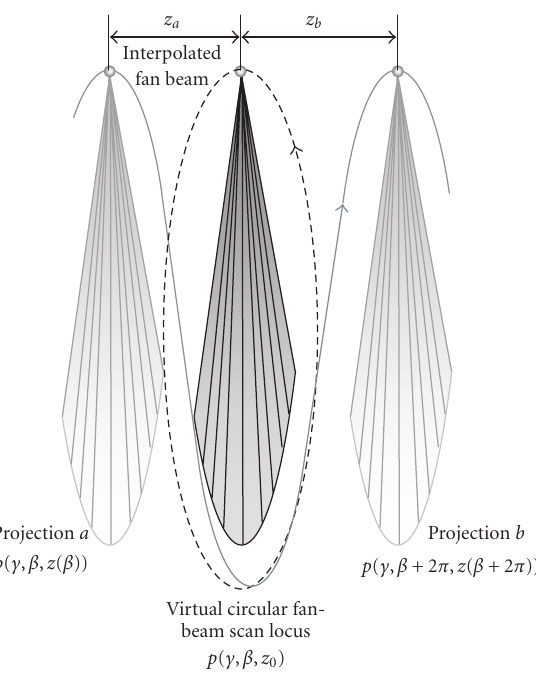
Figure 2: Helical data interpolation scheme. Helical scanning pro- jection data are rebinned into a series of circular scan datasets via linear interpolation.